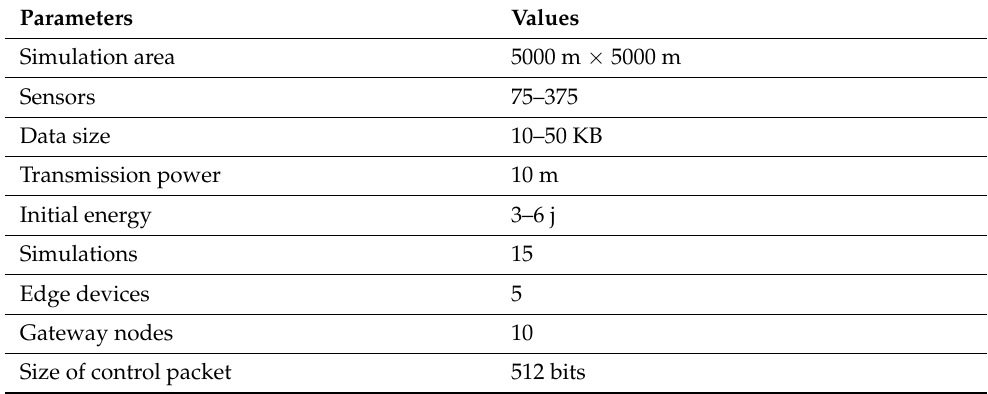
Table 1. Simulation